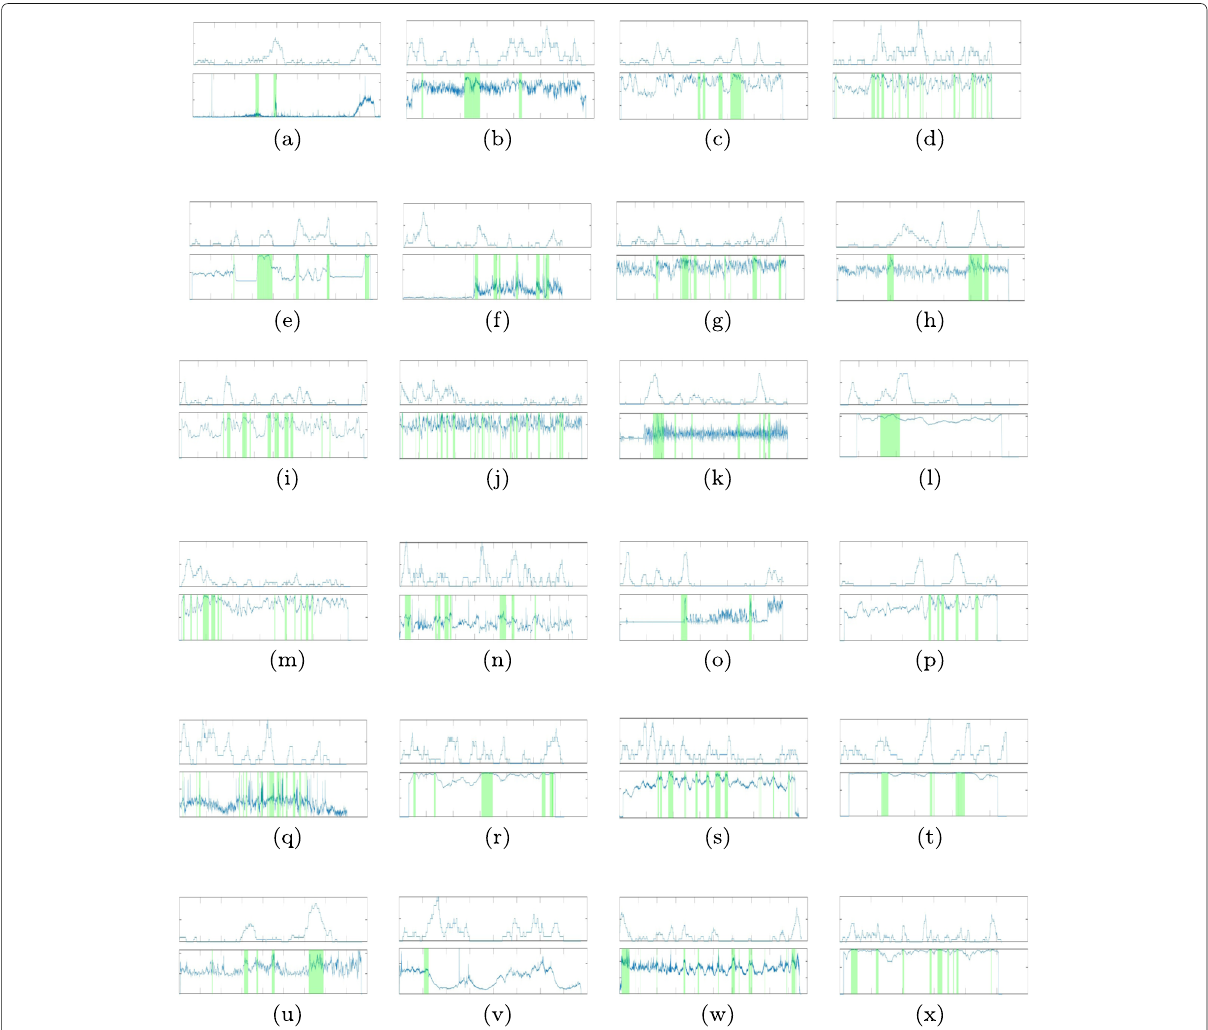
Fig. 3 Results illustration from videos in SumMe dataset with lengths 15%. For each video, the first graph shows Ground Truth (User annotated importance scores); the second graph shows our summarization results, where green bars indicate frames or clips selected by our method. a Air Force One. b Bearpark climbing. c Bike Polo. d Bus in rock tunnel. e Car over camera. f Car railcrossing. g Cockpit landing. h Cooking. i Eiffel Tower. j Excavators river crossing. k Fire domino. l Jumps. m Kids playing in leaves. n Notre Dame. o Paintball. p Paluma jump. q Playing ball. r Playing on water slide. s Saving dolphins. t Scuba. u St Maarten Landing. v Statue of Liberty. w Uncut evening flight. x Valparaiso